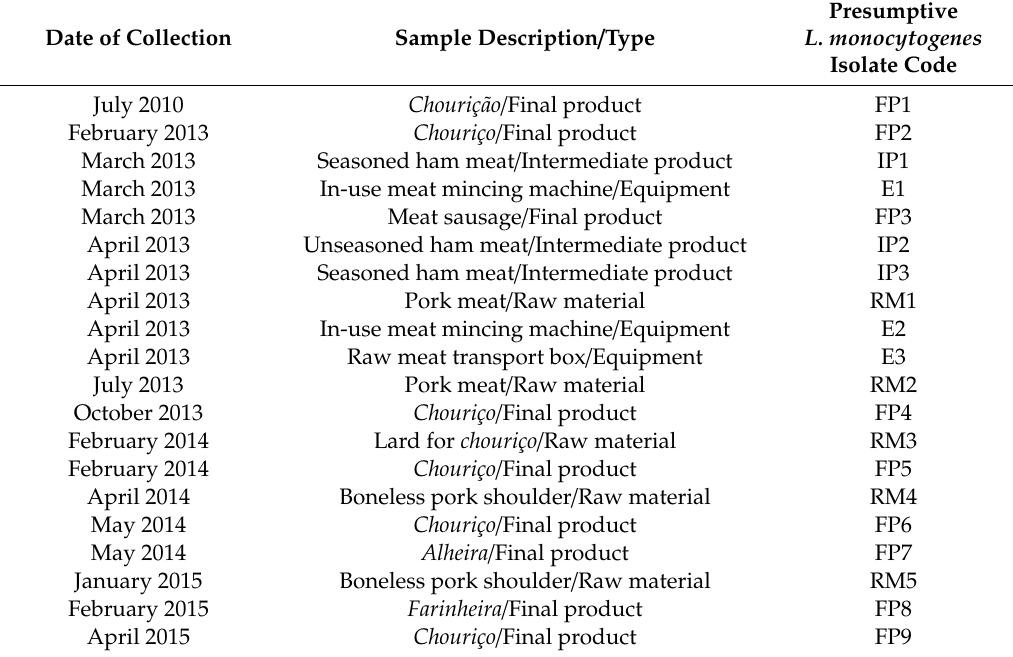
Table 1. Samplescollectedintheassessedindustrywithpositive L.monocytogenes detectionbyconventional microbiological methods.